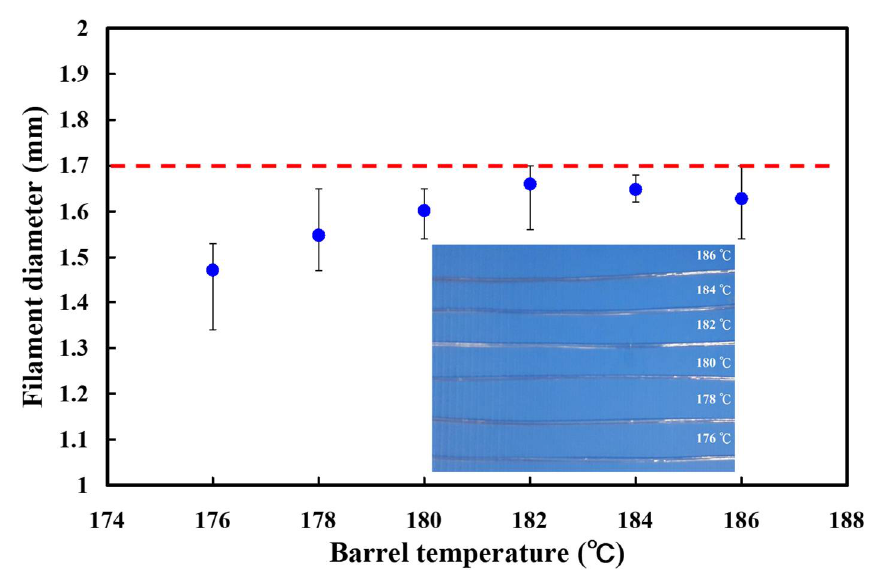
Figure 3. Effects of the barrel temperatures on the PLA filament diameter.